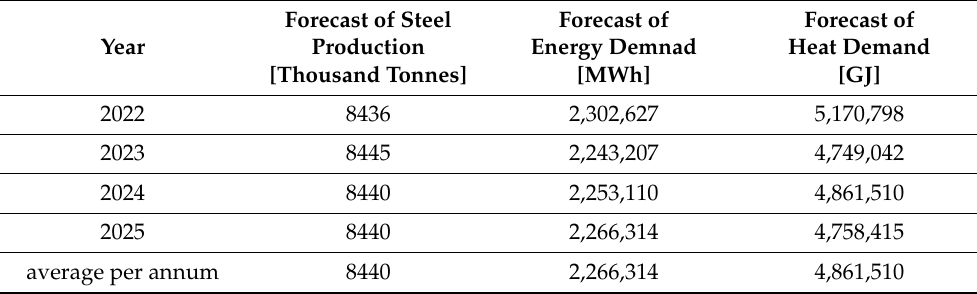
Table 4. Forecasts of energy and heat demand based on forecasting model used to determine the forecasts of steel production in 2022–2025 (variant